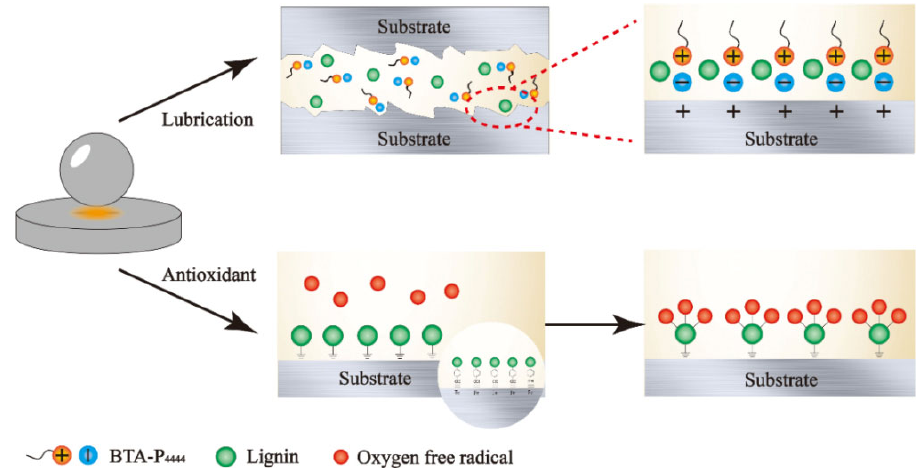
Fig. 14 Lubrication